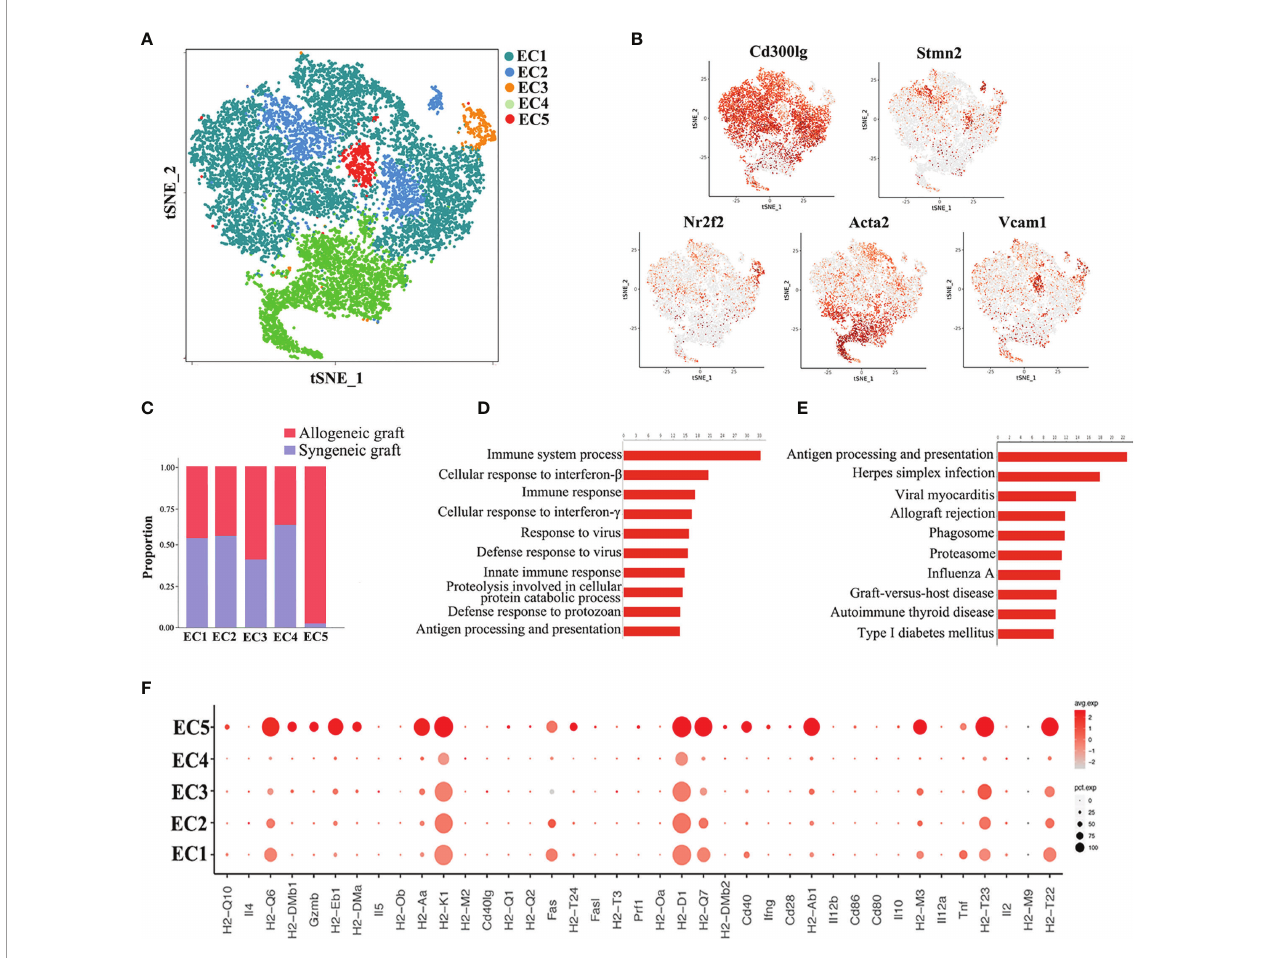
FIGURE 4 | Analysis of endothelial cell (EC) subsets. (A) Reclustering of endothelial cells identifying fi ve subsets. (B) Expression of canonical cell markers in each EC cluster (EC1-EC5) in the t-SNE plots. (C) Proportion of cells in each EC subset from allogeneic or syngeneic graft. (D) GO enrichment analysis of EC5. (E) KEGG pathway analysis of EC5. (F) A dot plot showing the expression of in fl ammatory genes and MHC class II molecules in each EC